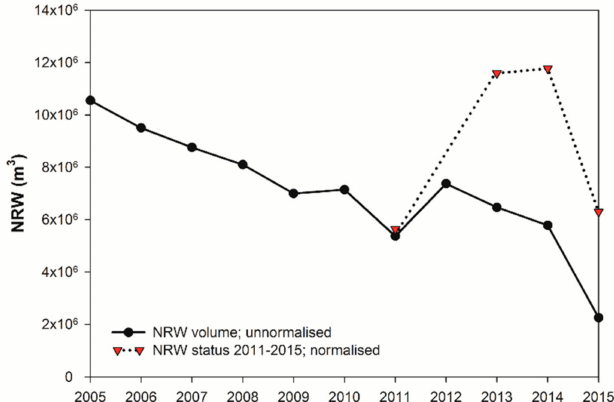
Figure 1. NRW volume (unnormalised, apparent trend) and NRW status (normalised trend) in